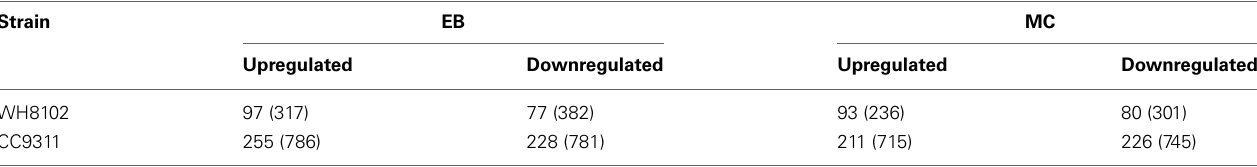
Table 1 | Numbers of genes in Synechococcus sp. WH8102 and CC9311 whose transcription was strongly (more than twofold) upregulated or downregulated under EB and MC shock treatments as detected by microarray analysis.